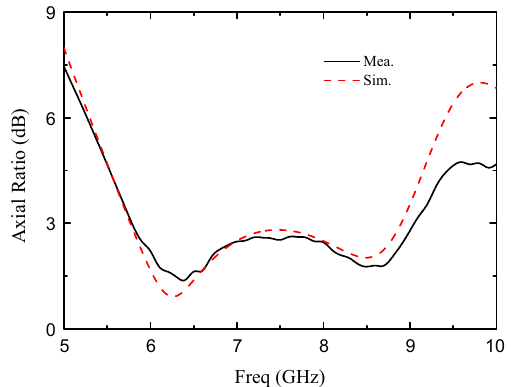
Fig. 11 The measurement curves of AR characteristics of the proposed UWB circularly polarized antenna. The simulation results are also included for the